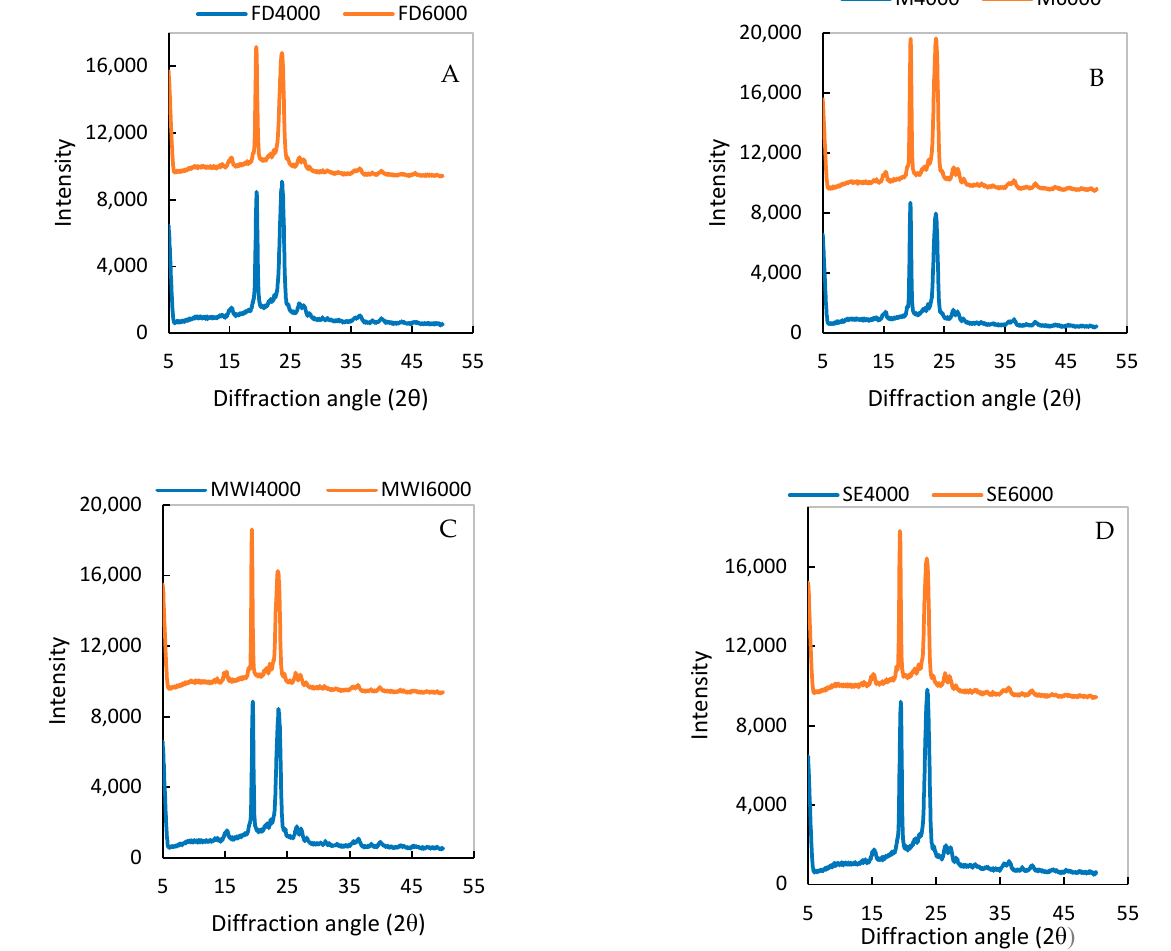
Figure 3. Powder X-ray diffraction patterns of the solid dispersions of MOLP using PEG as a carrier prepared through ( A ) freeze-drying method (FD4000 and FD6000), ( B ) melting method (M4000 and M6000), ( C ) solvent evaporation (SE4000 and SE6000), and ( D ) microwave irradiation method (MWI4000 and MWI6000).